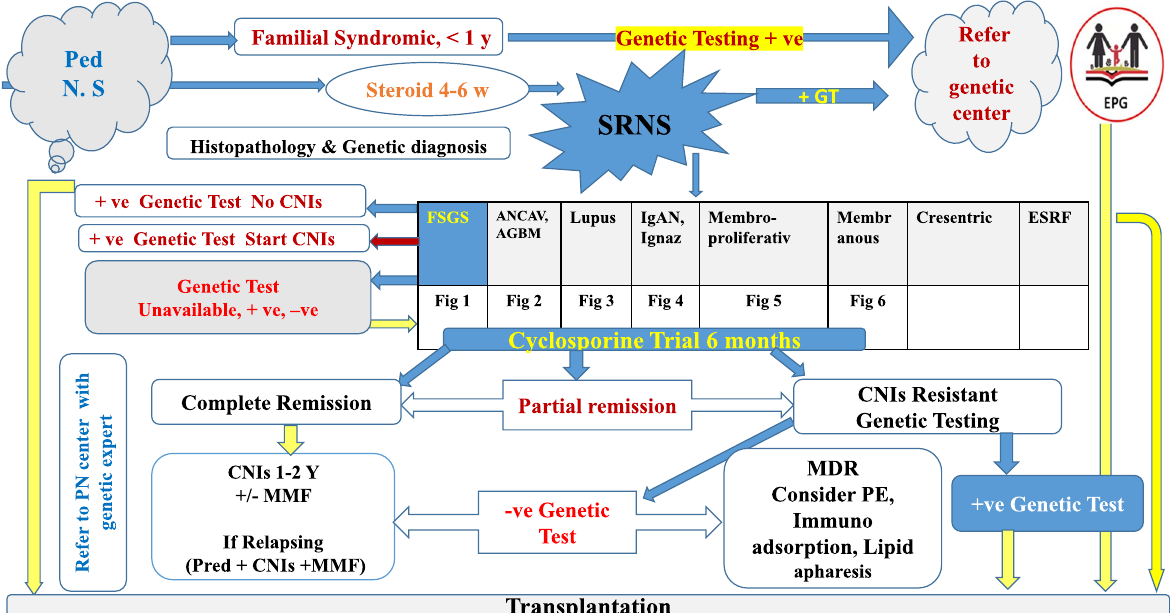
Fig. 8 EPG/SRNS management flow chart. R